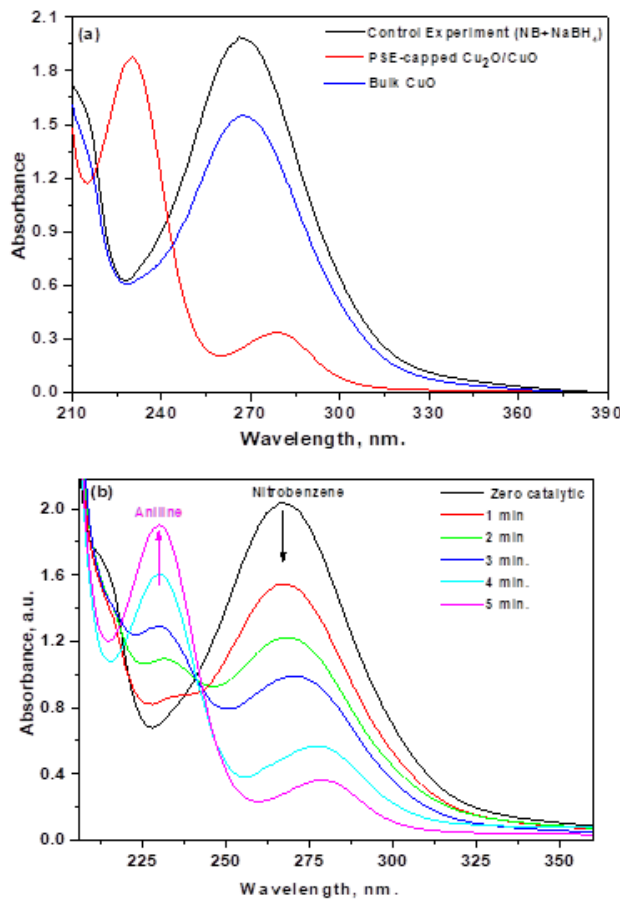
Figure 6. Catalytic properties of the synthesized catalysts. ( a ) UV-vis absorption spectra of the reduction of NB over bulk fabricated CuO and PSE-capped Cu 2 O / CuO catalysts and ( b ) UV-vis absorption spectra displaying gradual reduction of NB over PSE-capped Cu 2 O / CuO (1 mg catalyst, 5 mg NaBH 4 , 2.5 × 10 − 4 mol L − 1 NB).